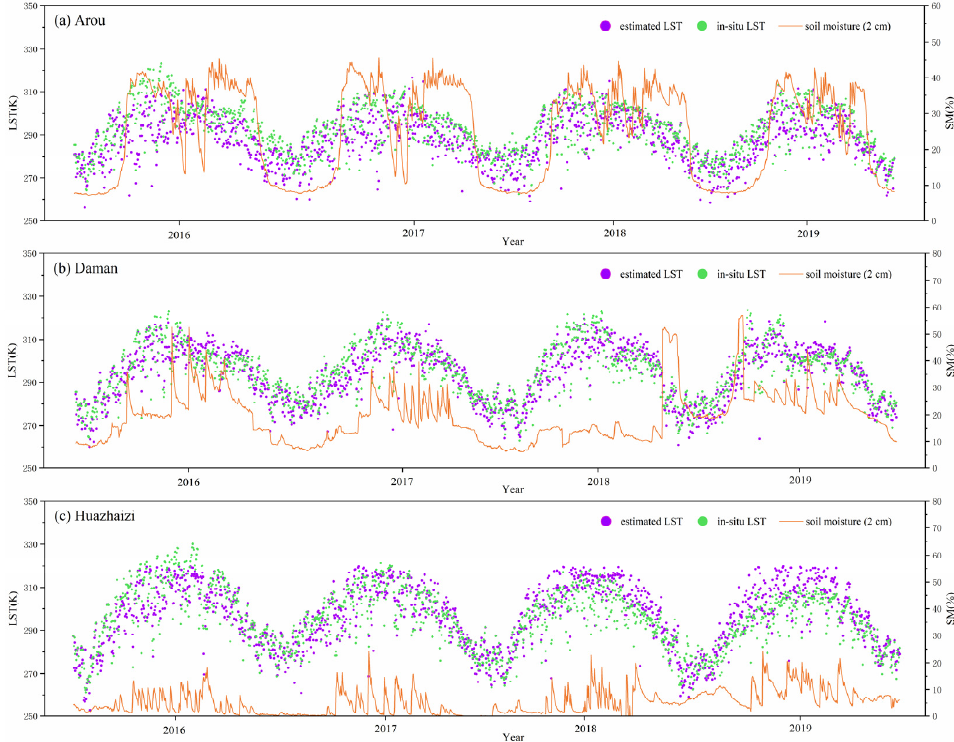
Figure 9. Comparison of soil moisture with LST reconstructed by classification and adaptive window at different sites from 2016 to 2019.